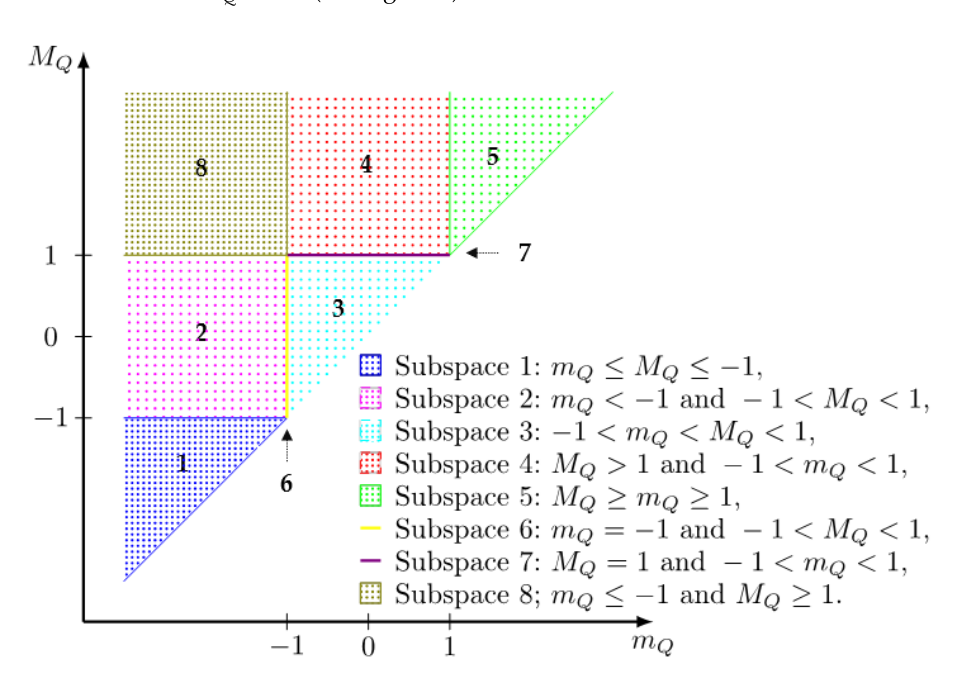
Figure 1. The set of possible values m Q and M Q